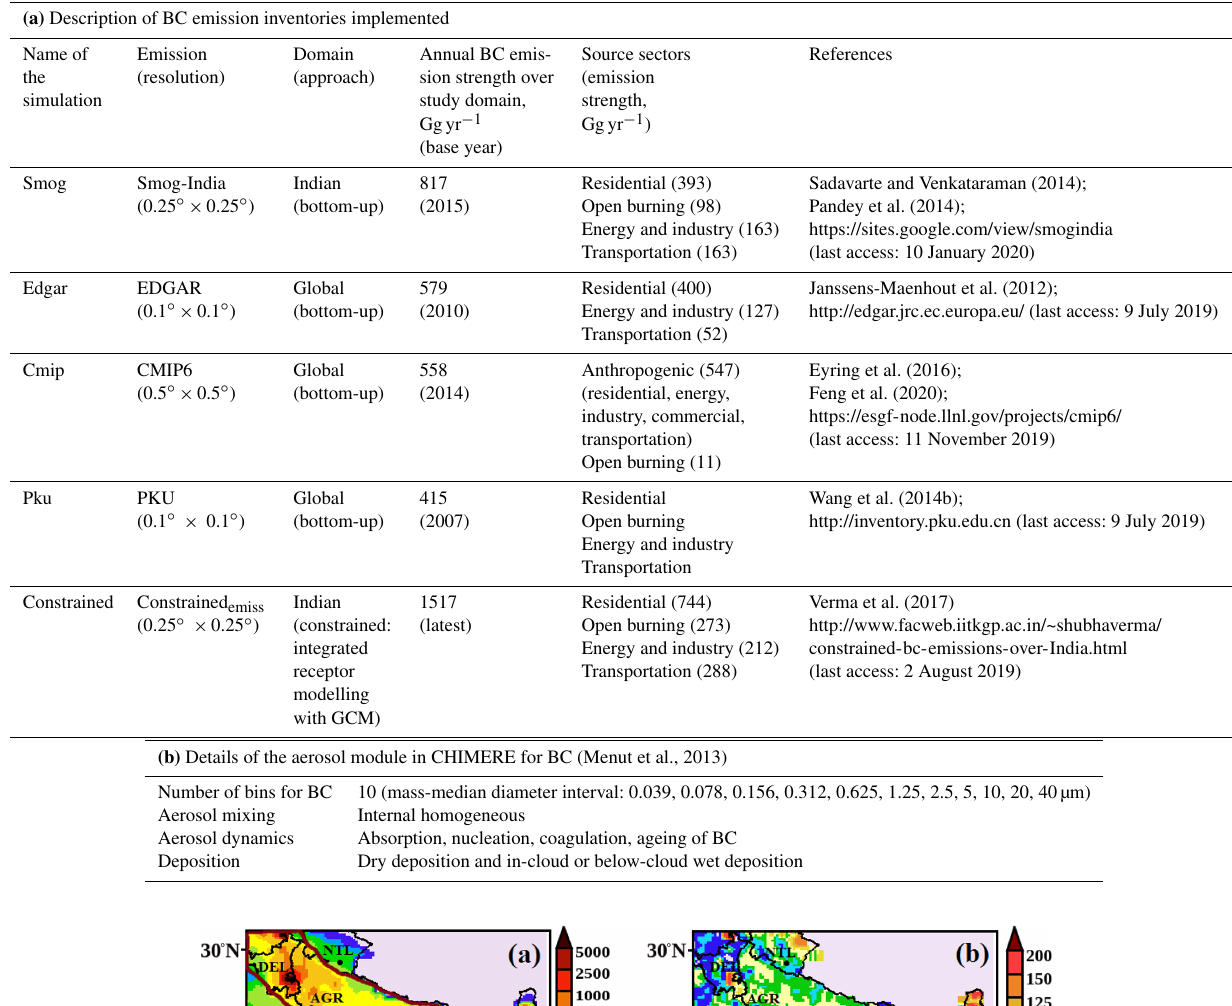
Table 1. Experimental set-up for the simulation of BC with CHIMERE. (a) Description of BC emission inventories implemented